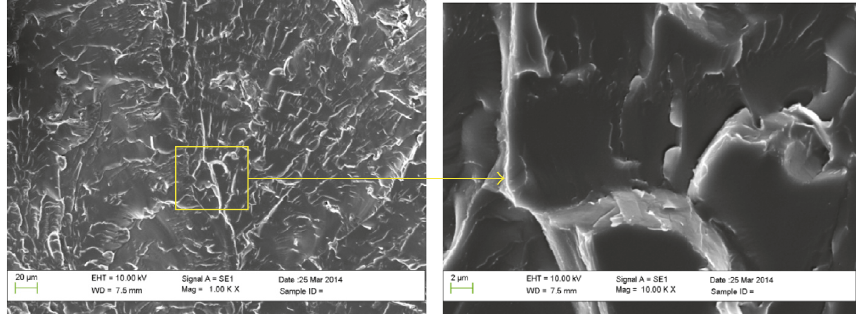
Figure 6: SEM images at low and high magnifications of fracture surfaces of PET-GNP nanocomposites containing 6wt.% of GNP.